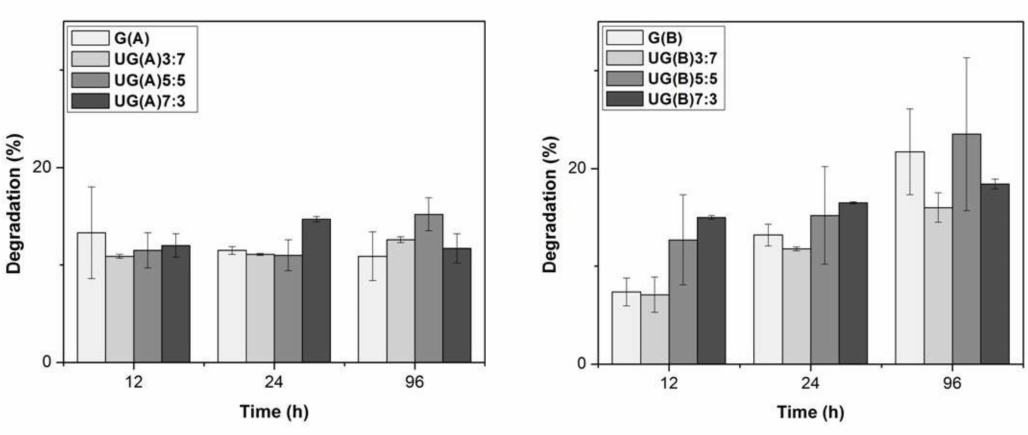
Figure 6. Degradation (%) of UG sca ff olds as a function of incubation time at 37 ◦